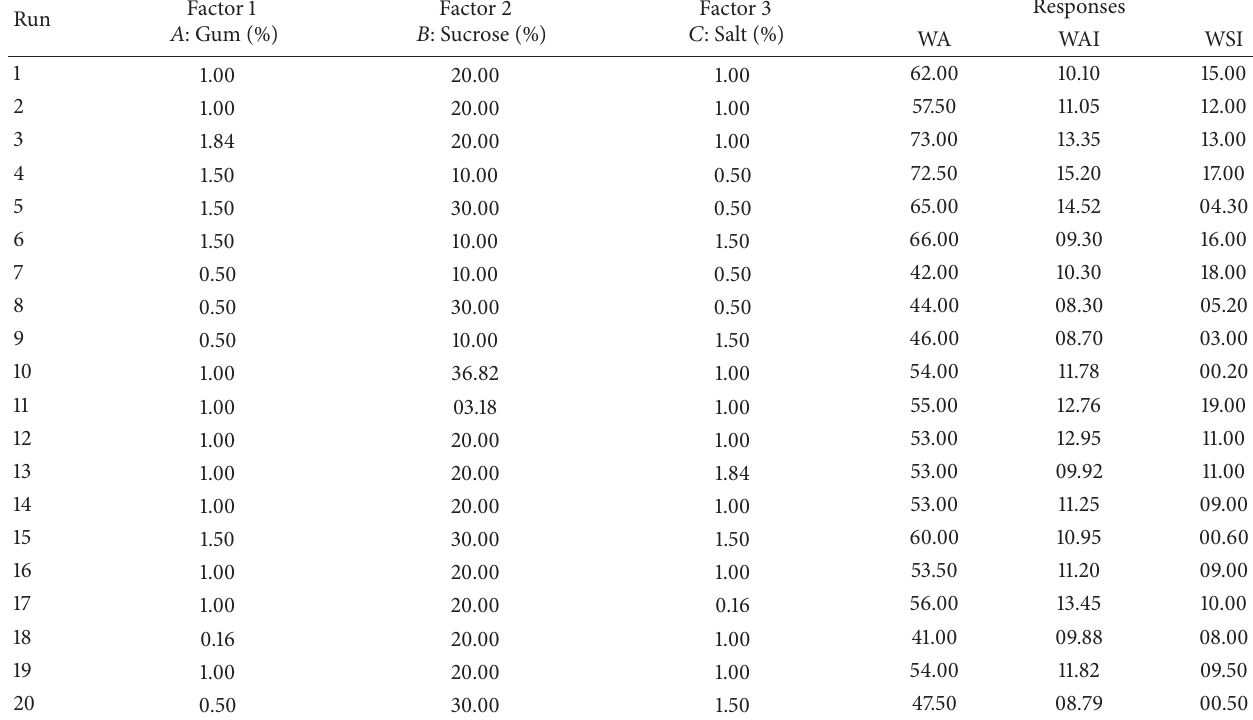
Table 2: Experimental design depicting levels of additives and their responses in lotus stem starch.